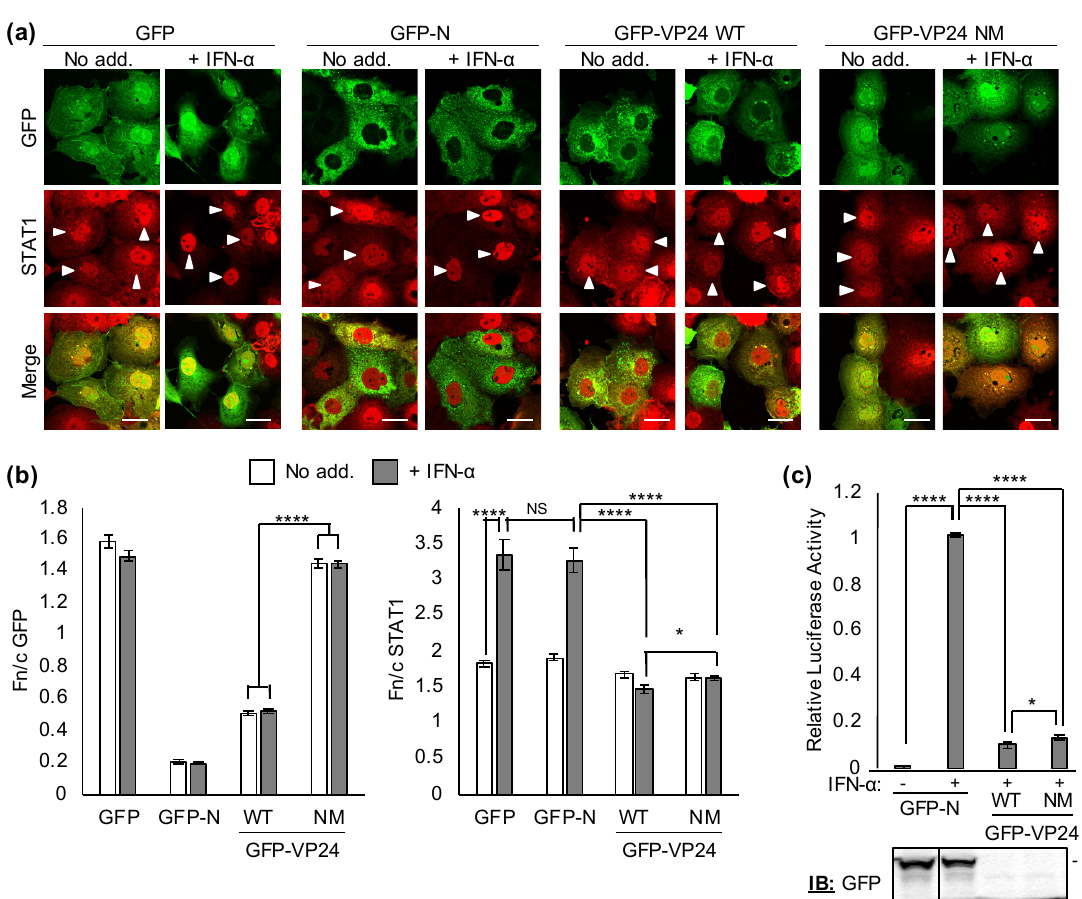
Figure 3. EBOV VP24 NES is dispensable for IFN/STAT1 antagonism. ( a , b ) COS7 cells transfected to express the indicated proteins were treated 24 h post-transfection with or without IFN- α (30 min) before fixation, immunofluorescent staining for STAT1 (red) and CLSM ( a ) to determine the Fn/c for GFP and STAT1 ( b ); mean ± SEM, n ≥ 36 cells. Arrowheads indicate cells with detectable GFP expression. Scale bars, 30 μ m. ( c ) HEK293T cells co-transfected with pISRE-Luc and pRL-TK, and plasmids to express the indicated GFP-fused proteins, were treated 8 h post-transfection with or without IFN- α (16 h) before determination of luciferase activity (mean ± SEM; n = 4 independent assays); lower panel : cell lysates used in a representative assay were analyzed by immunoblotting (IB) for GFP. *, p < 0.05; ****, p < 0.0001; NS, not significant; No add., no addition.